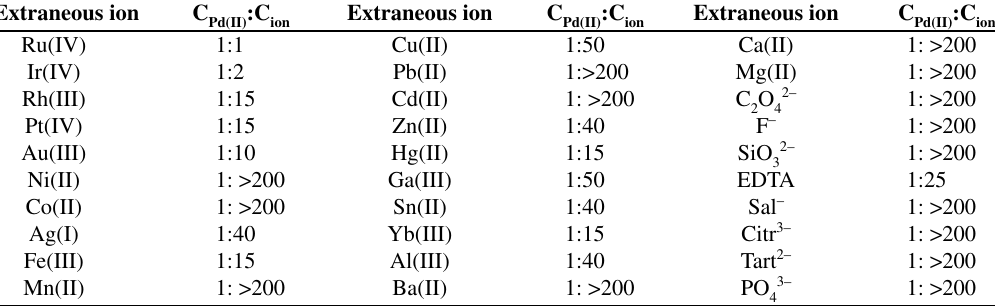
Table 2. Tolerance ratios of extraneous ions during the spectrophotometric determination of Pd(II) in the presence of 4- [ N ’-(4-imino-2-oxo-thiazolidin-5-ylidene)-hydrazino ] -benzenesulfonic acid (C(ITHBA) = 1.0 × 10 –4 mol L –1 ;